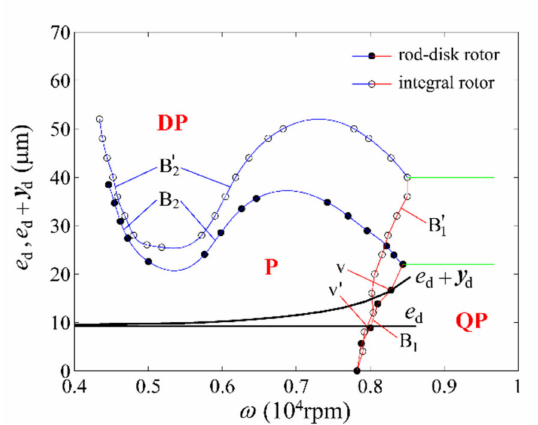
Figure 8. Global stability areas, boundaries, and their relationships with the mass eccentricity and rotor bending for both rod–disk and integral rotor.